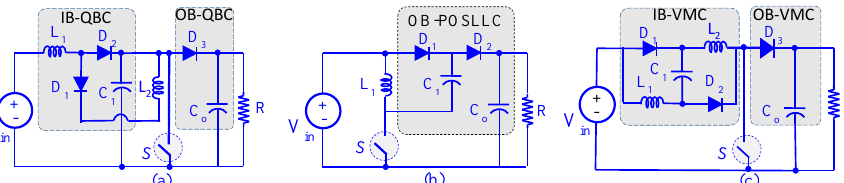
Figure 1. ( a ) Cascaded boost converter, ( b ) positive output super lift Luo converter, ( c ) modified form of the boost converter by a voltage multiplier